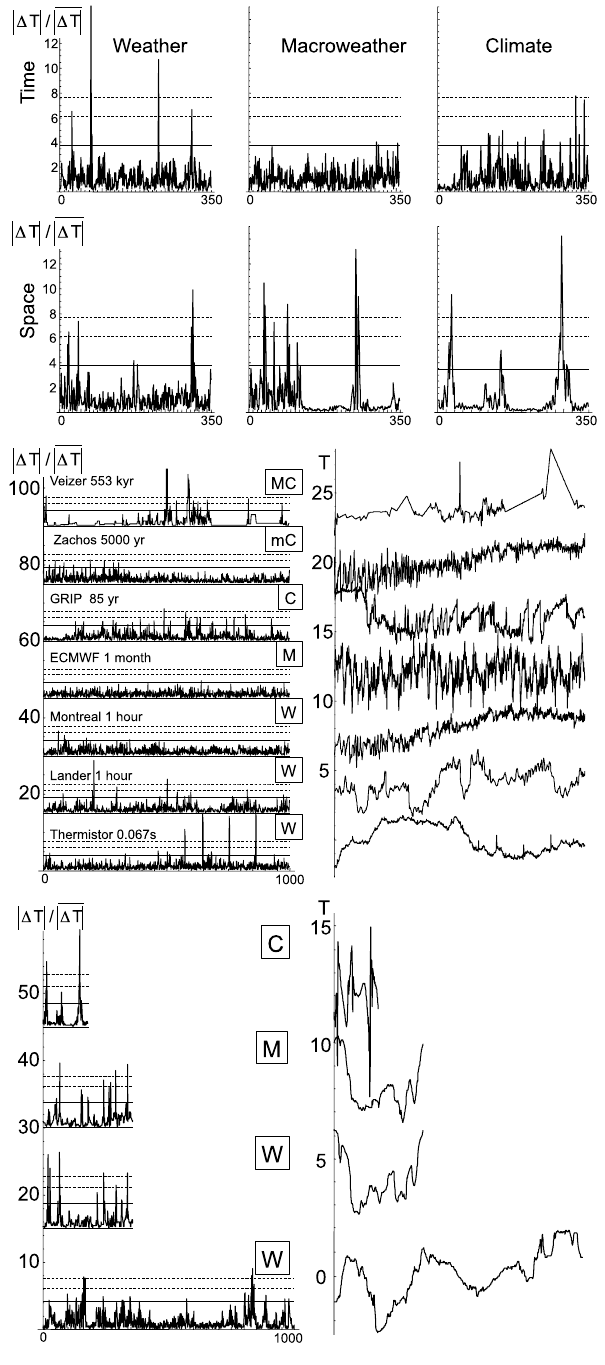
Figure 2. (a) (top panel): Temperature spike plots for weather, macroweather, climate (left to right) and time and space (top and bottom). The solid horizontal black line indicates the expected maximum for a Gaussian process with the same number of points (360 for each with the exception of the lower right which had only 180), the dashed lines are the corresponding Gaussian probability levels p = 10 − 6 , p = 10 − 9 , two of the spikes exceed 14; p < 10 − 77 . The upper left is Montreal at 1 hour resolution (data set #3; these numbers refer to Table 1), upper middle, Montreal at 4 month resolution (#4), upper right, GRIP at 240 year resolution (#5), lower left, aircraft at 280 m resolution (#9), ECMWF, space, one month, 1° in space (#11), Twentieth Century Reanalysis (20 CR), 140 year res, 2° in space at 45°N, (#12). ( b ) (middle panel): Left: similar to ( a ) but for time only, and all series have 1000 points; the original series (normalized by their standard deviations and displaced vertically by 15 units for clarity) are shown on the right in the corresponding order. Bottom to top: The data are from sets #1,#2, #3, #4, #5, #7, #8 (Table 1). The “mC” and “MC” are for macro and mega climate respectively. The solid horizontal lines are the Gaussian levels corresponding to probability of 10 − 3 , the dashed lines are for 10 − 6 , 10 − 9 . (c) (bottom panel): Same as ( a ) but for transects, bottom to top: length 1000 (aircraft, data #9), daily reanalysis (360 points, #10), monthly reanalysis, #11, 360 points, 140 year resolution, #12, 180